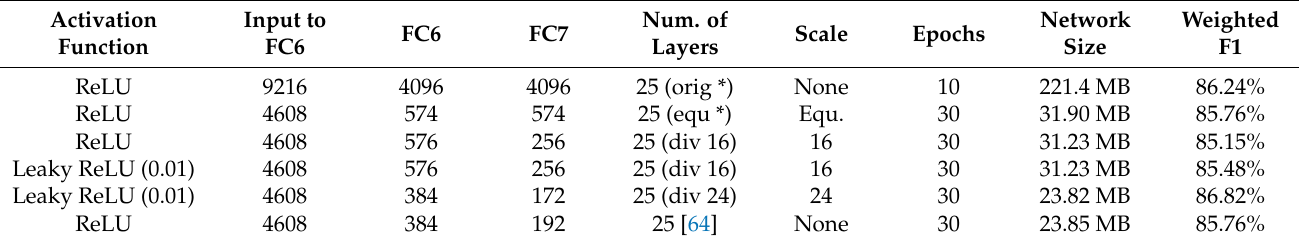
Table 7. Parameter Modification